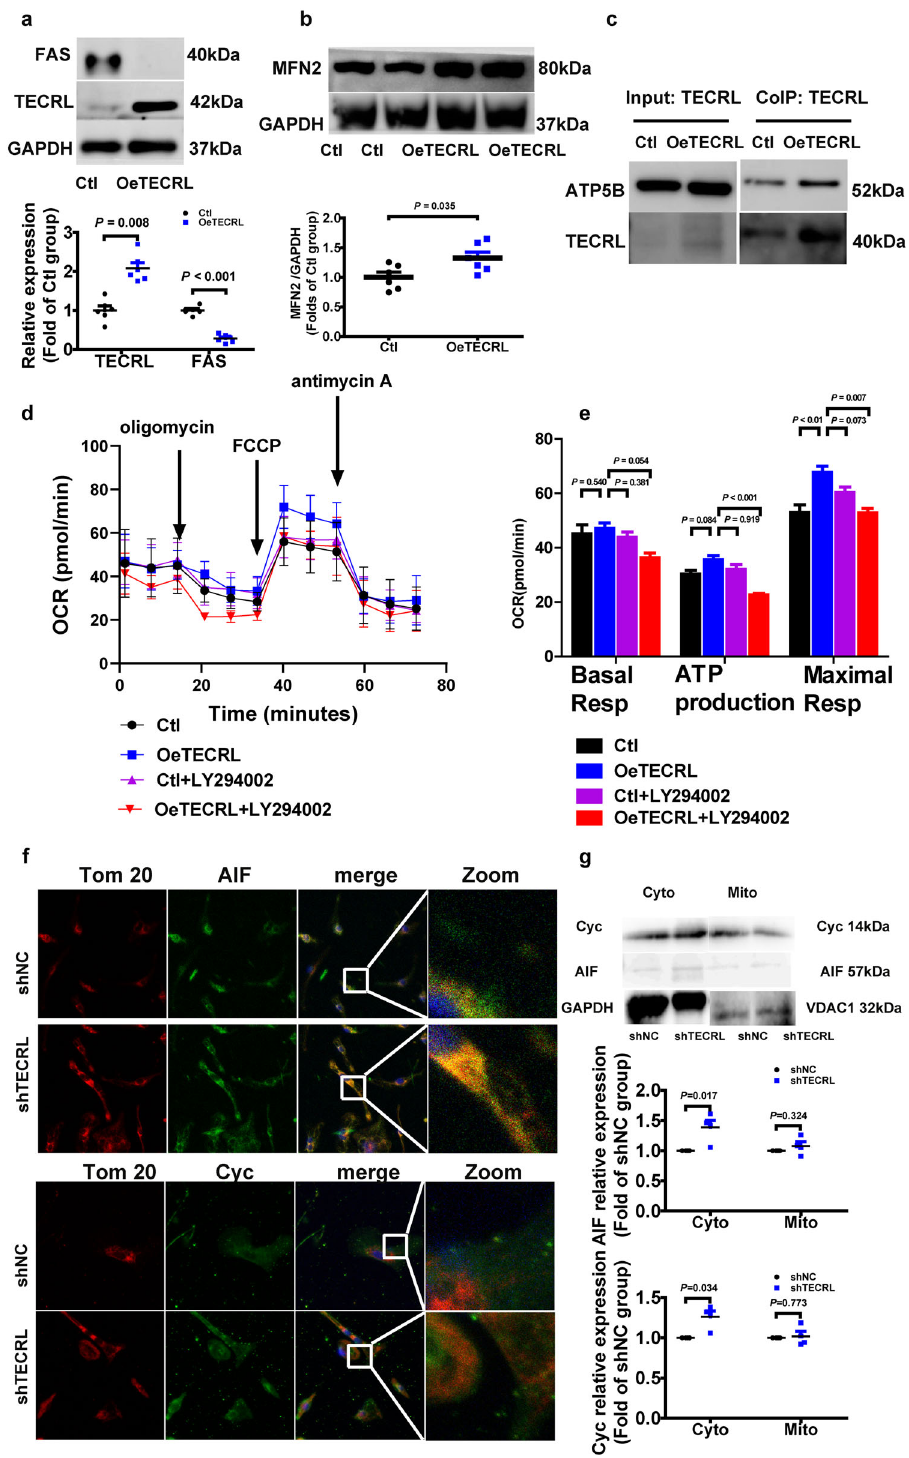
Fig. 7 Overexpression of TECRL can induce mitochondrial respiration in hiPSC-CMs. a , b Representative immunoblotting images and quanti fi cation of the expression of FAS, MFN2, and TECRL of hiPSC-CMs following TECRL overexpression ( n = 6). c Representative images of co-immunoprecipitation of TECRL and ATPB ( n = 3). d , e Measurements of OCR and respective quantitative analysis in hiPSC-CMs ( n = 12). f Representative images of Cyc and AIF colocalization with Tom 20 in hiPSC-CMs ( n = 6). Scale bar = 10 μ m. g Cyc and AIF released from the mitochondria into the cytoplasm were analyzed by western blotting. VDAC1 was used as a loading control for mitochondria gradients. GAPDH was used for cytosolic gradient ( n = 4). Values are mean ± SE. P < 0.05 was considered signi fi